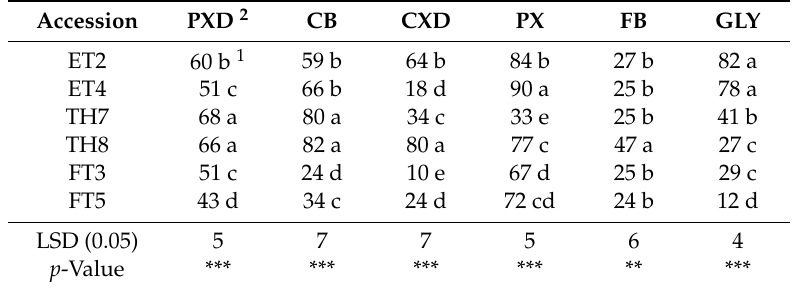
Table 4. E ffi cacy of several herbicides on E. colona accessions at 21 days after treatment (21 DAT). Dry weight of each accession was expressed as % of control.